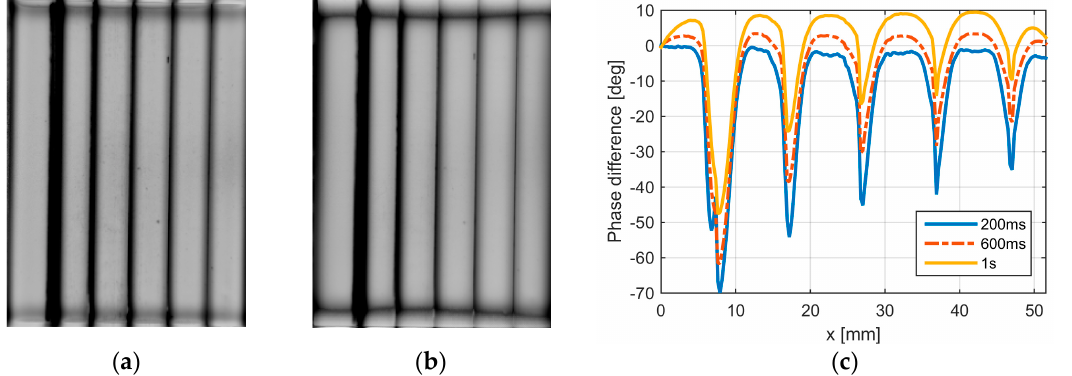
Figure 33. Phase images for a non-magnetic steel sample with five artificial defects, each of them with a 1 mm depth, and inclination angles of 75°, 60°, 45°, 30° and 0° from left to right, respectively; ( a ) t pulse = 0.1 s; ( b ) t pulse = 0.6 s; ( c ) profiles for different heating pulses.